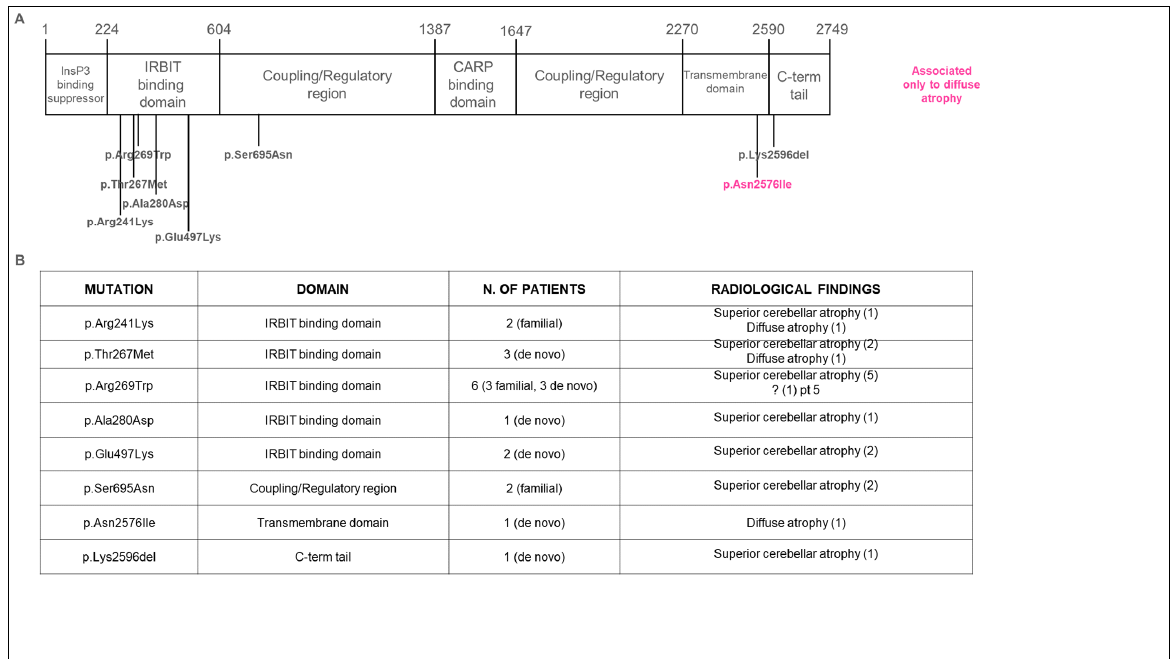
Figure 1. Genetic findings in enrolled patients. ( A ) Schematic representation of the position of variants within functional domains of the ITPR1 protein. Most variants are located in the IRBIT domain, suggesting that loss of the channel function impairs the IP3-induced Ca 2+ release. ( B ) Summary of variants and radiological features found in our cohort.